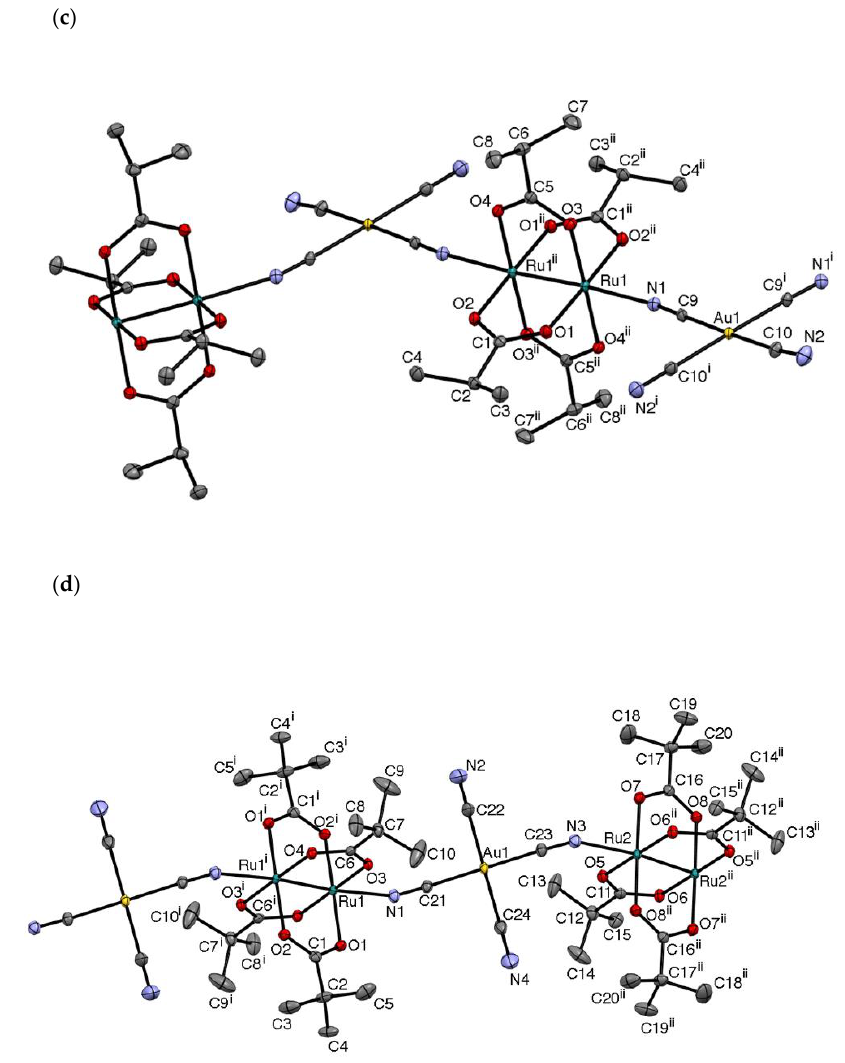
Figure 3. The ORTEP view of molecular structures of ( a ) [Ru 2 (CH 3 COO) 4 Au(CN) 4 ] n ( 1 ), ( b ) [Ru 2 (C 2 H 5 COO) 4 Au(CN) 4 ] n ( 2 ), ( c ) [Ru 2 ( i -C 3 H 7 COO) 4 Au(CN) 4 ] n ( 3 ), and ( d ) [Ru 2 ( t - C 4 H 9 COO) 4 Au(CN) 4 ] n ( 4 ), with thermal ellipsoids (50% probability level). The hydrogen atoms have been omitted for clarity.